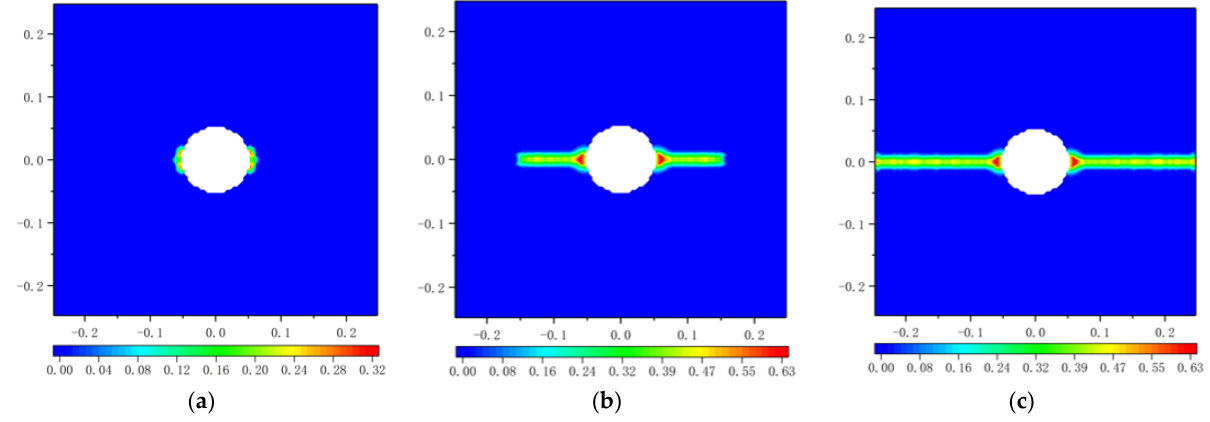
Figure 23. Damage plots for the square plate with a circular hole at the end of different time steps